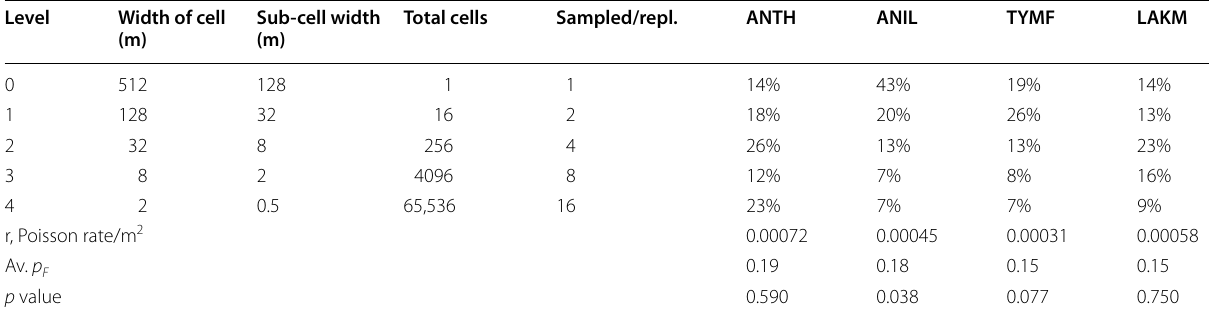
Table 2 The density measured as the level of occupancy in the four populations we studied and the corresponding parameters for the fractal and Poisson